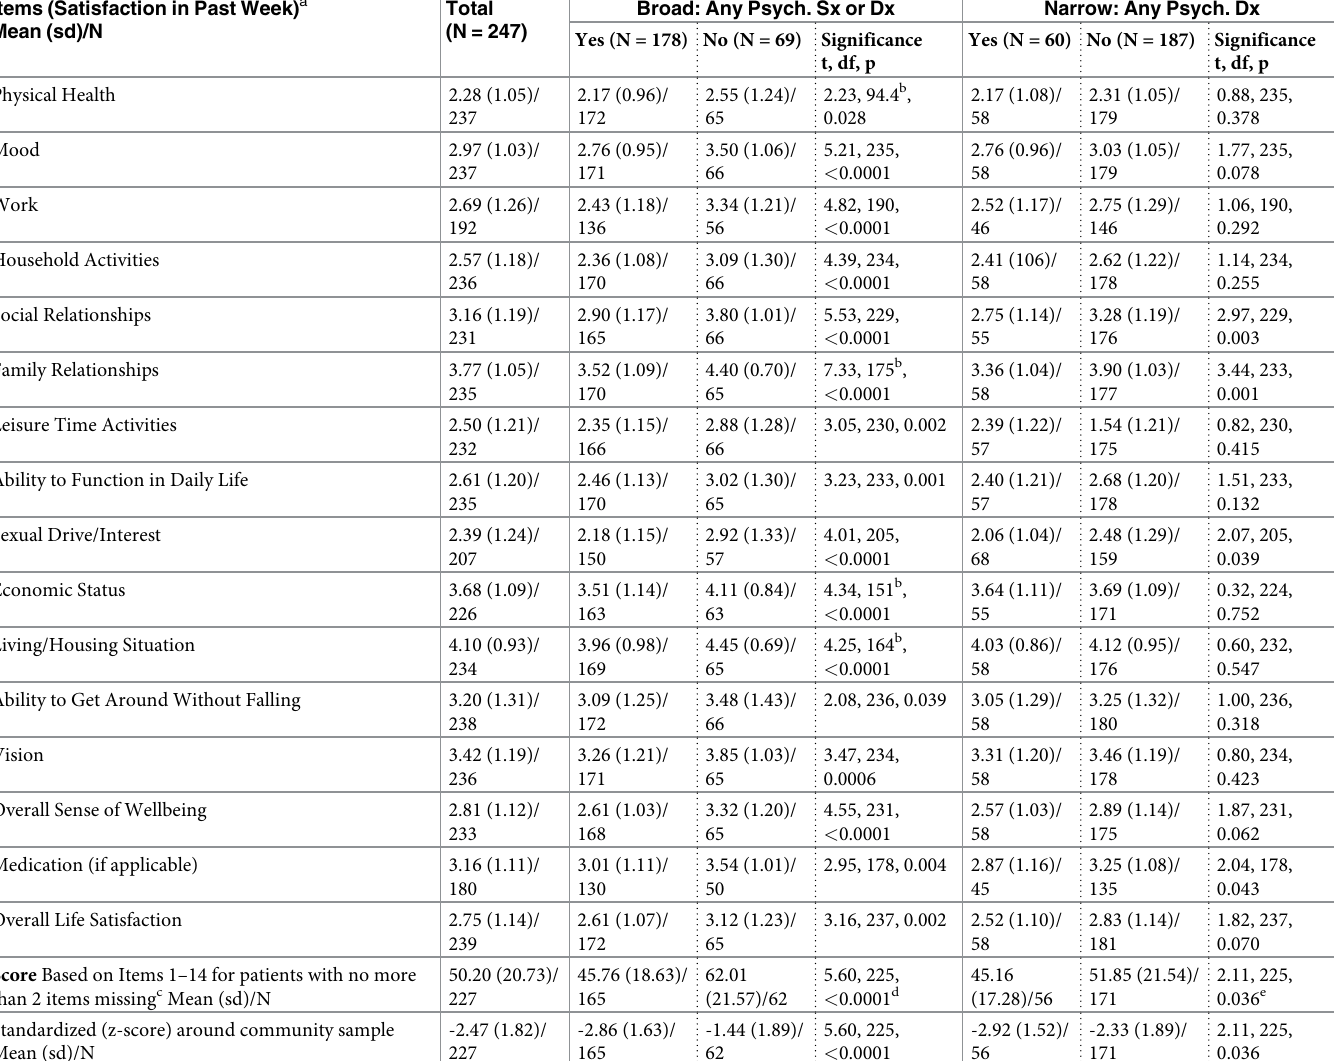
Table 4. Quality of life enjoyment and satisfaction a for ESDS sample (N = 247). Overall Sample and By Broad and Narrow Definitions of Psychiatric Complaints at Intake. Items (Satisfaction in Past Week) a Mean